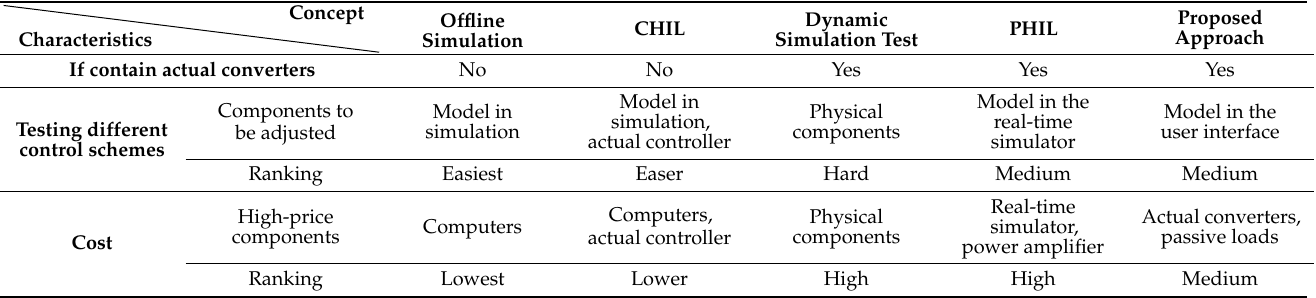
Table 3. Comparisons of different concepts for testing microgrid